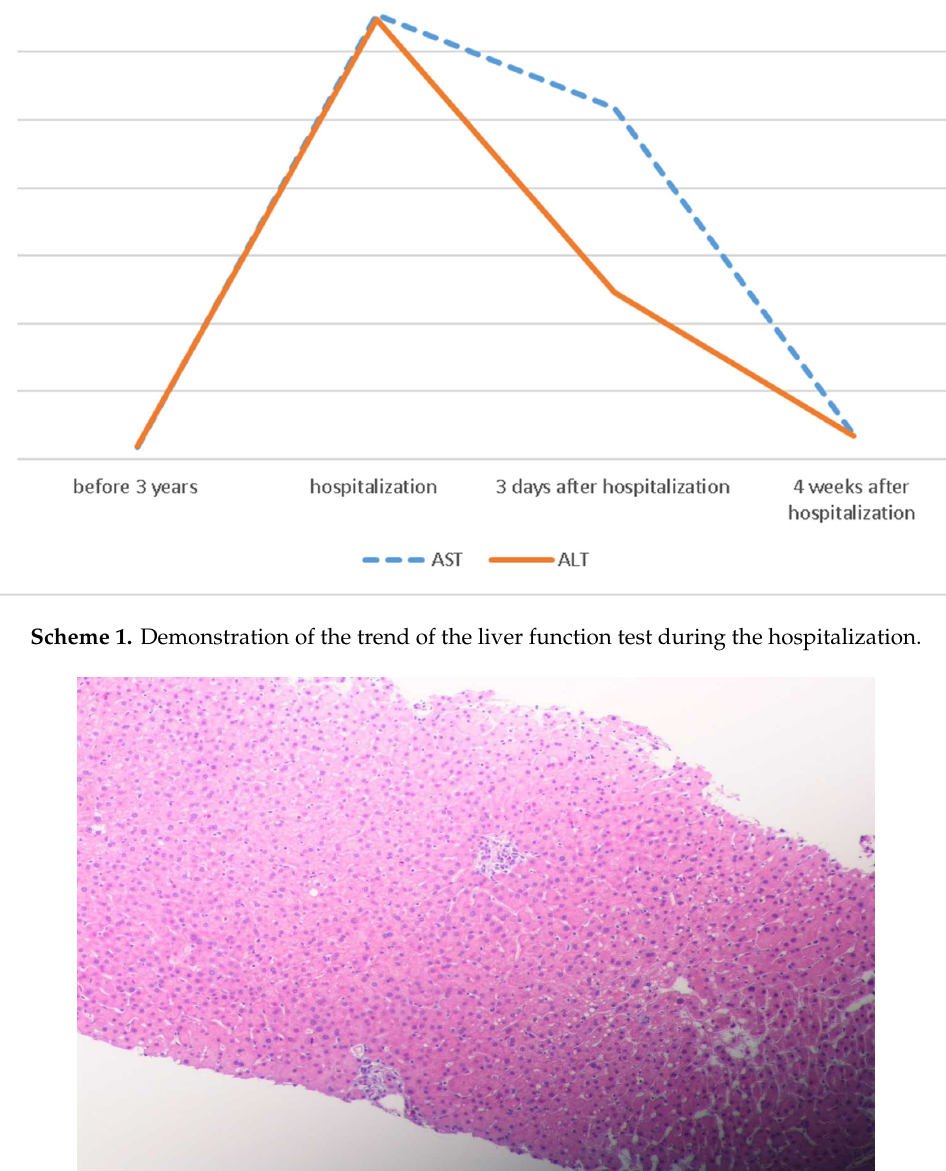
Figure 2. Lobular hepatitis with intra-acinar spotty necrosis. Lymphohistiocytic (blue spotter) and eosinophilic cell (orange spotter) infiltration consistent with drug-induced hepatitis (H&E magnification ×400, high power.) 3. Discussion Khat is a socially accepted recreational substance that is indigenous to East African and Middle Eastern countries. Khat use is prevalent in Yemen, Somalia, Somaliland, Kenya, Djibouti, and Ethio- pia, especially in men. In a study among Ethiopian college students, 41% of students had used Khat once in a lifetime, usually in conjunction with alcohol [5]. In another study, 34% of the Somali immi- grant population in the United Kingdom reported use of Khat [6]. The majority of them use Khat in moderation and adverse events are usually associated with excessive use [7]. Khat is made from the leaves of the shrub Catha Edulis. The active ingredients of Khat are struc- turally related to amphetamine and phenylethylamines [8]. It is known to increase alertness and it is usually used for euphoria. The physiological elimination can lead to depression, insomnia and lack of appetite. Khat use can increase the diastolic blood pressure [9] and has several adverse cardiac outcomes. Khat-related hepatotoxicity is well reported, though requires a high index of suspicion in suspected cases.